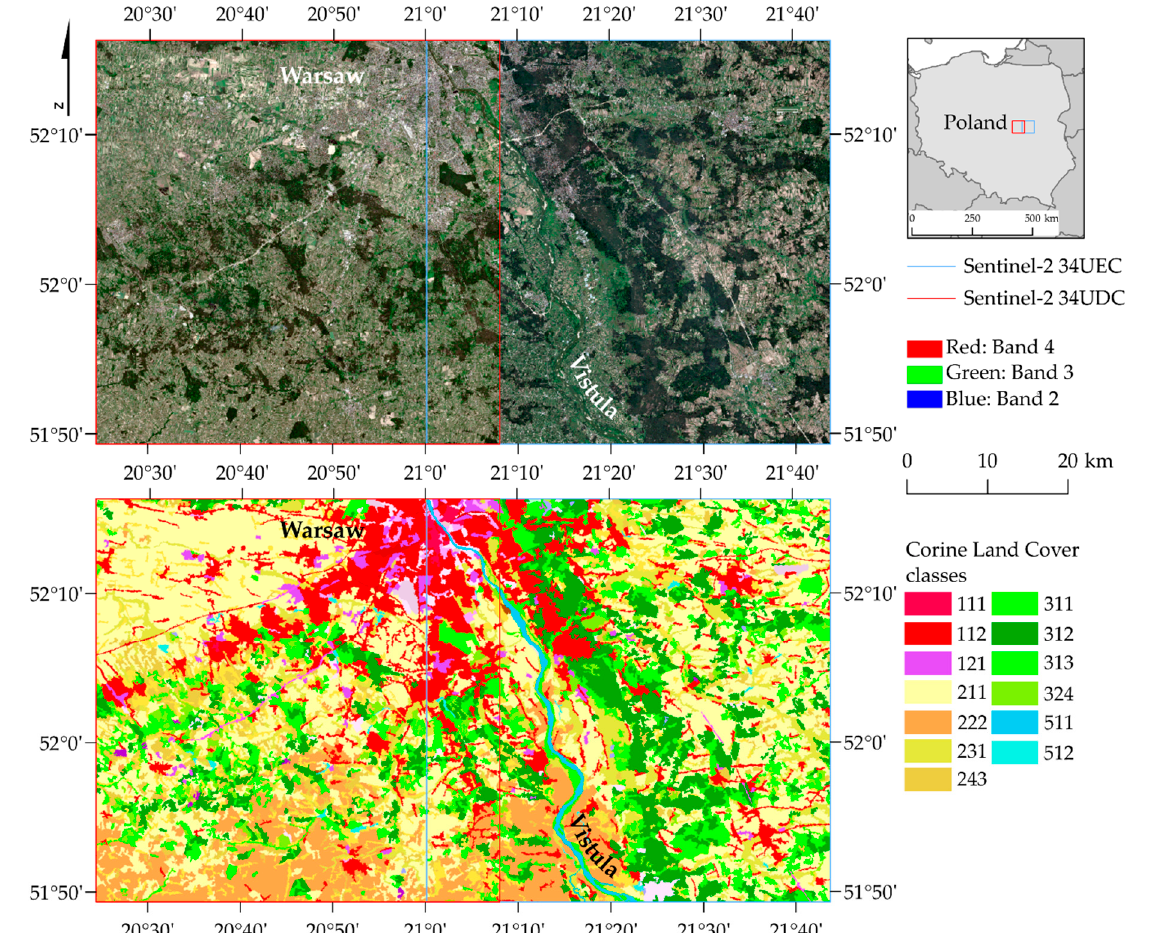
Figure 3. Location of West and East Warsaw areas (source: own study based on Sentinel-2 images, ESA, 2018 and the Corine LC map of the European Environment Agency, 2018). Codes: 111: continuous urban fabric; 112: discontinuous urban fabric; 121: industrial or commercial units; 211: non-irrigated arable land; 222: fruit trees and berry plantations; 231: pastures; 243: land principally occupied by agriculture, with significant areas of natural vegetation; 311: broad-leaved forest; 312: coniferous forest; 313: mixed forest; 324: transitional woodland/shrub; 511: water courses; 512: water bodies.